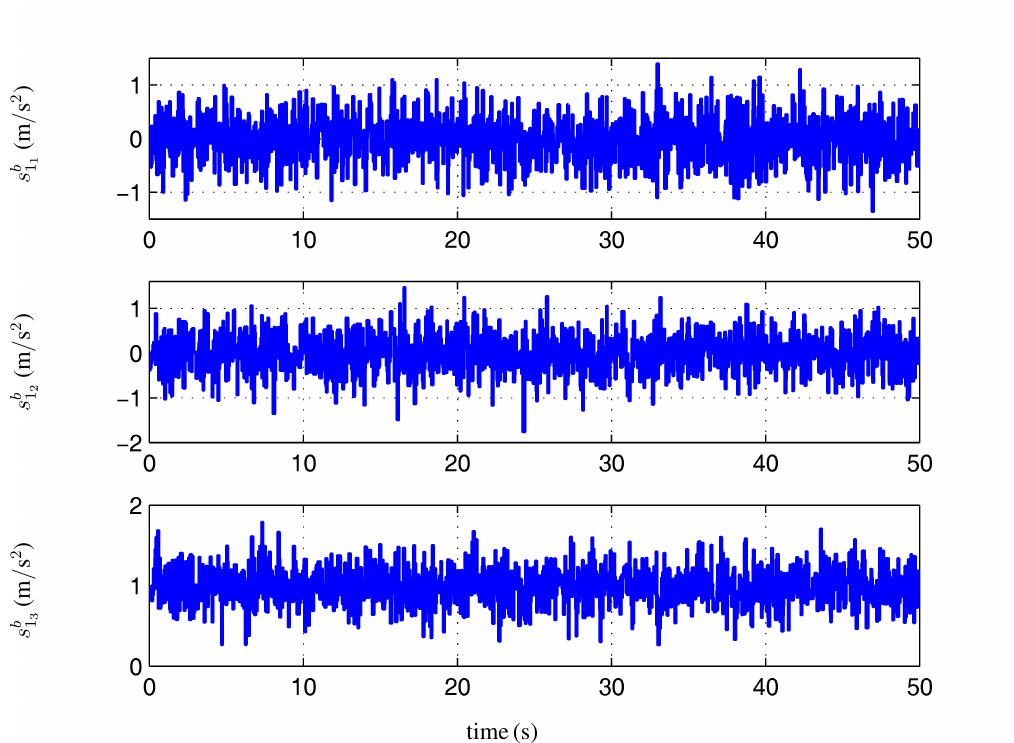
Figure 8. Control law of Corollary 1: the evolution of the accelerometer measurement s b